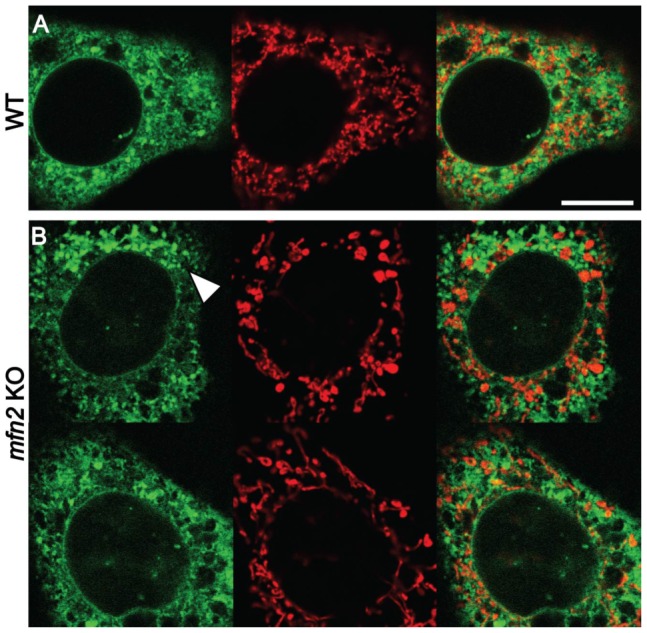
Fluorescence analysis of ER and mitochondria.WT (A) and mfn2 KO cells (B) were co-transfected with a GFP-coupled ER marker (green) and an RFP-coupled mitochondrial marker (red). After fixation, confocal images were acquired and used to quantify Manders' colocalization coefficients (Table 5). The arrowhead indicates a region of a mfn2 KO cell where the ER appears dilated. Bar: 10 µm.